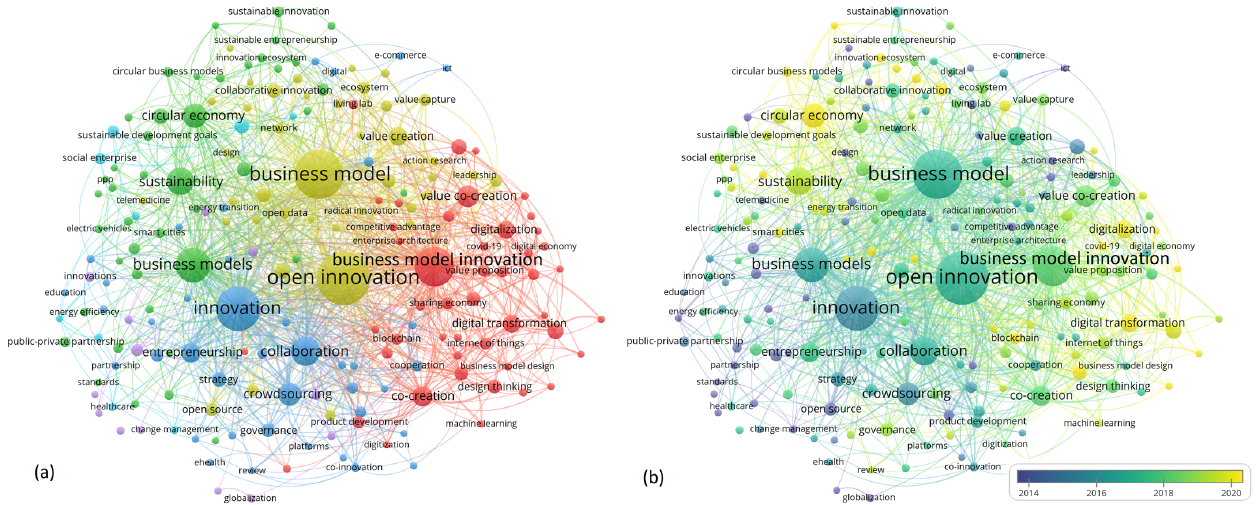
Figure 4. Co-occurrence network of authors’ keywords of the BM&OI literature: ( a ) general division into clusters, and ( b ) division on the time axis.